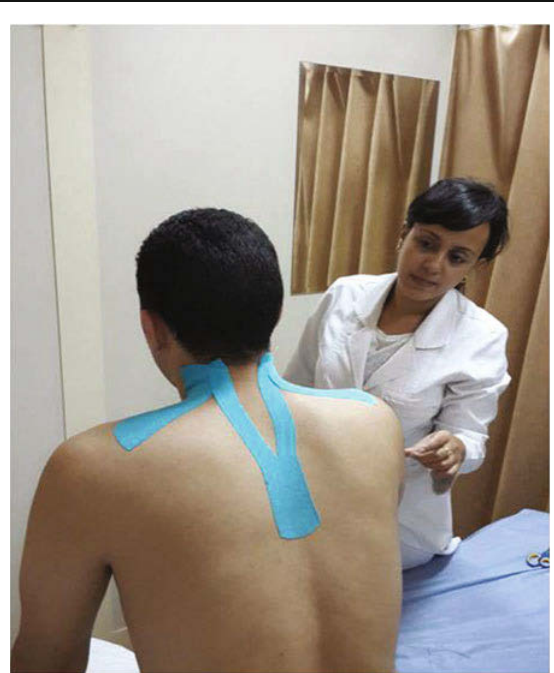
Kinesio taping application to the cervical